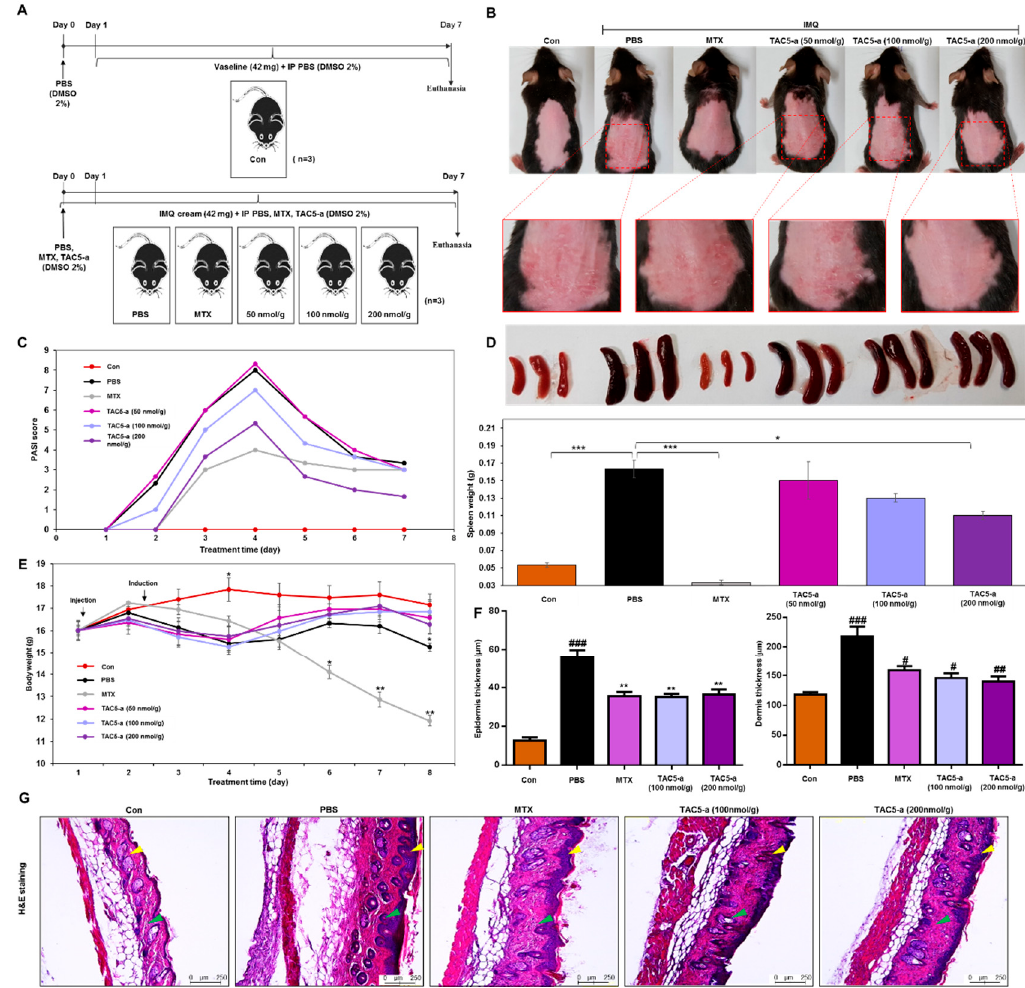
Figure 4. Effect of TAC5-a in a mouse model of psoriasis. ( A ) Summary of the experiment for evaluating the therapeutic effect of TAC5-a on a psoriasis mouse model. Psoriasis was induced by applying imiquimod (IMQ) cream (5%) on the shaved back skin of C57BL/6 male mice ( n = 3). Mice were treated with daily doses of PBS as a control and 50, 100, and 200 nmol/g of TAC5-a intraperitoneally (IP). Methotrexate (MTX; 20 µg/g) was administered as a positive control from one day before applying IMQ cream as a pretreatment. ( B ) Photographs of shaved mouse back skin on day 4 to monitor the effect of TAC5-a on psoriasis condition. ( C ) Scoring of disease severity based on the clinical Psoriasis Area and Severity Index (PASI). Orange, dark blue, and green lines indicate the PASI index of mice treated with TAC5-a at 50, 100, and 200 nmol / g, respectively. ( D ) E ff ect of TAC5-a on spleen weight. ( E ) Body-weight dynamics of mice during the treatment regimen. ( F ) The thickness of the epidermis and dermis in TAC5-a and MTX (positive control) group. ( G ) The Histopathological changes of back skin lesions of each group. Skins were stained with hematoxylin and eosin to evaluate the thickness of the epidermis (yellow arrow) and dermis (green arrow) in IMQ-induced psoriasis-like mice. The skin thickness of each group was measured with the Leica DMi8 fluorescence microscope. Data represent mean ± SEM from five skin tissue of each group by two-tailed Student’s t -test, # p < 0.05, ## p < 0.01, ### p < 0.001, * p < 0.05, ** p < 0.01, *** p <